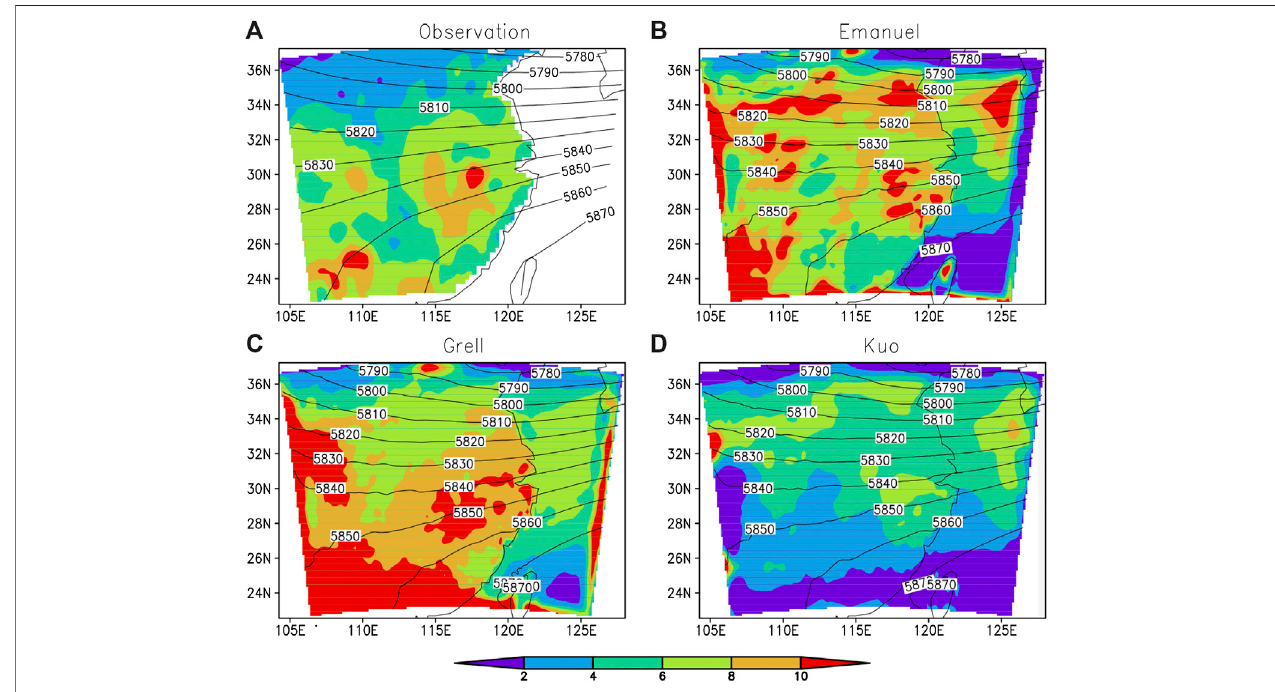
FIGURE 4 | Yangtze Meiyu distribution (shaded) and 500-hPa geopotential height (contours, unit: gpm) averaged over the 55-year period from 1955 to 2009 for observations and simulations by the Emanuel, Grell, and Kuo schemes.